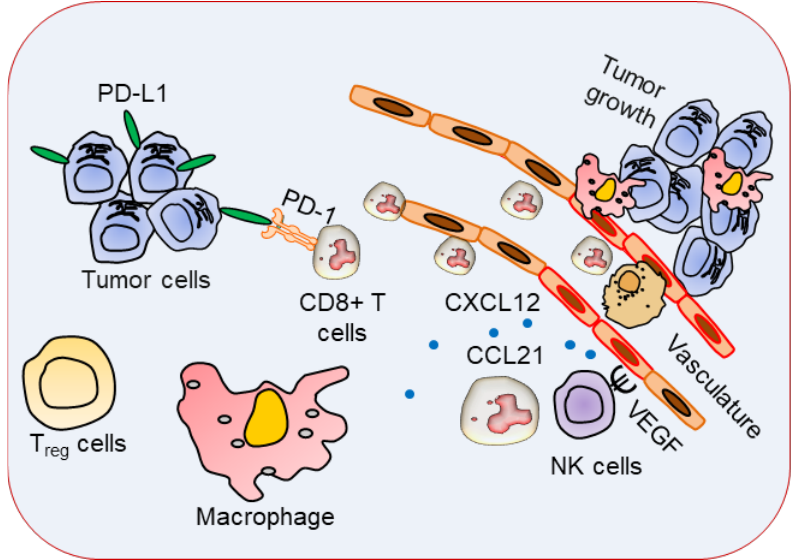
Figure 2. Lymphangiogenesis role in tumor microenvironment. Tumors infiltrated with immune cells with Treg and CD8+ effector T cells become functionally inhibited by the effects of PD-L1 expressing tumor cells. Lymphatic vessels expressing chemokine receptors CXCR4 and CCR7 binds to respective ligands CXCL12 and CCL21, leading organ tumors to metastasize.